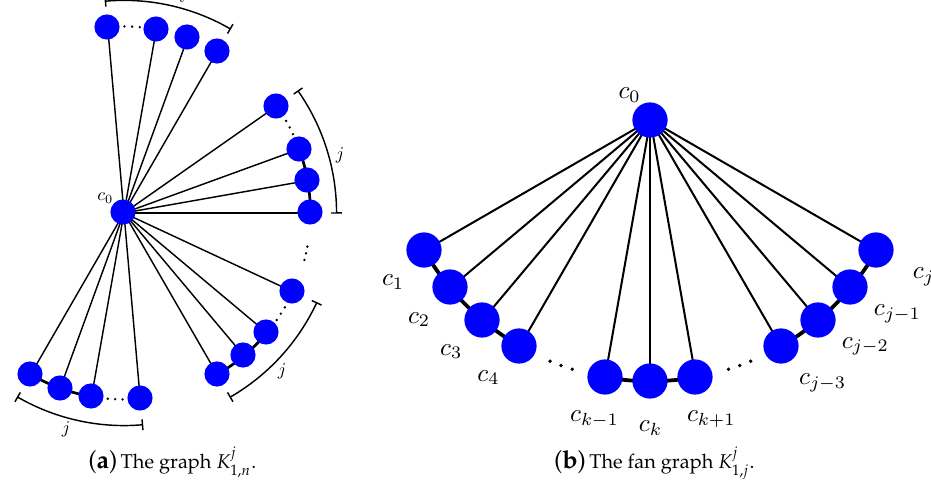
Figure 1. The graph K j